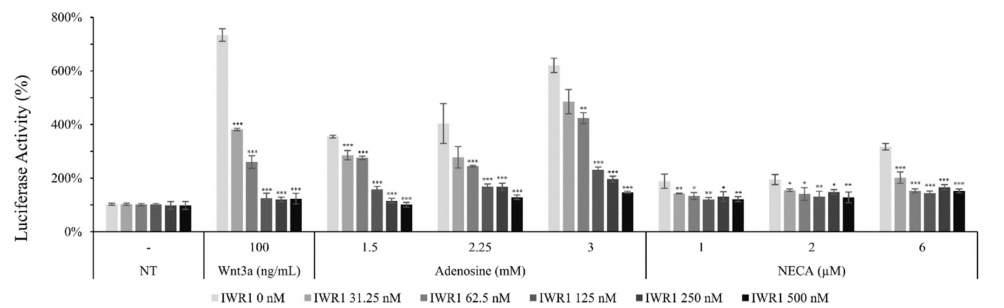
Figure 6. Adenosine stimulated canonical Wnt/ β -catenin signaling pathway. The luciferase activity in WRHEK293A reporter cells was assessed after treatment with adenosine and NECA for 24 h in the presence/absence of IWR1, a Wnt inhibitor. Wnt3a was used as a positive control. The data represent the means of six independent samples. N.T, non-treated control; Significantly different compared with N.T (* p < 0.05, ** p < 0.01, *** p < 0.001).